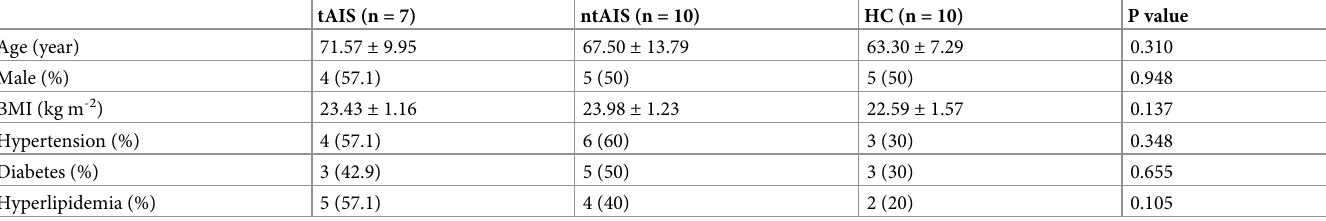
Table 1. Baseline characteristics of each